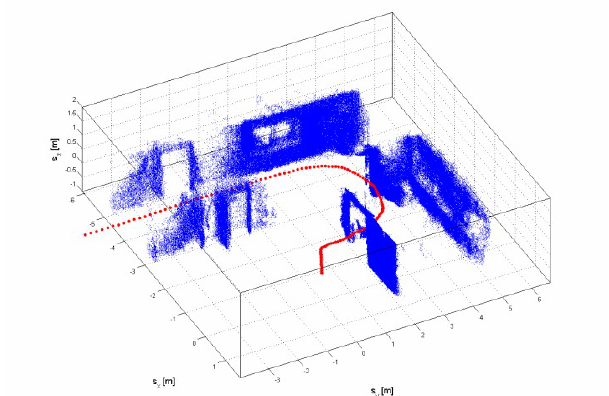
Figure 9: Combined IPS trajectory (doted red) and 3D point cloud (blue)